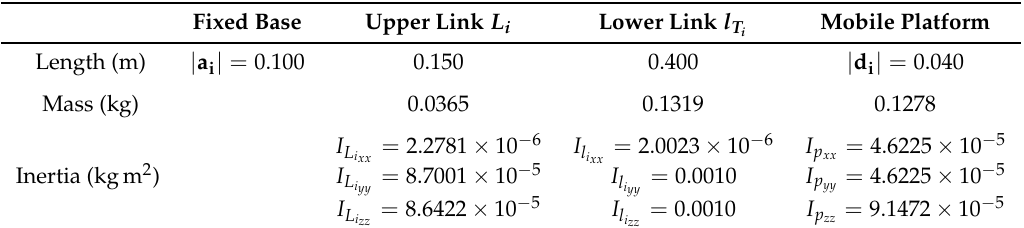
Table 1. Parameters of Omron Mini Delta CR-UGD4MINI-NR.